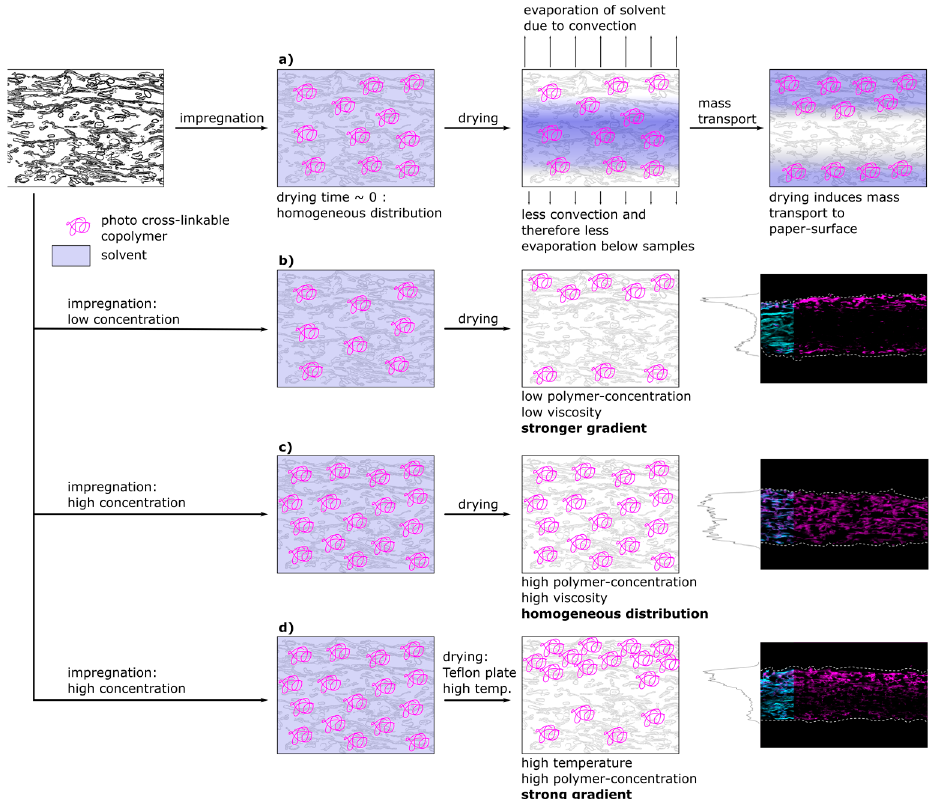
Figure 8. Model representation of a drying-induced transport in paper samples impregnated with copolymer solutions possessing different concentrations under various drying conditions, based on our conceptual understanding and the conducted experiments. For the cross-sections prepared by fluorescent CLSM the fibers are stained with FB (cyan color, outline continued) and the copolymer fluoresces due to the rhodamine B label (magenta).Upon impregnation the macromolecules are distributed homogeneously throughout the paper sample before being transported towards the surfaces during drying ( a ); conceptual representation at low ( b ) or high ( c ) polymer concentrations during impregnation and drying; combination of high concentration, increased temperature and limited drying (d).